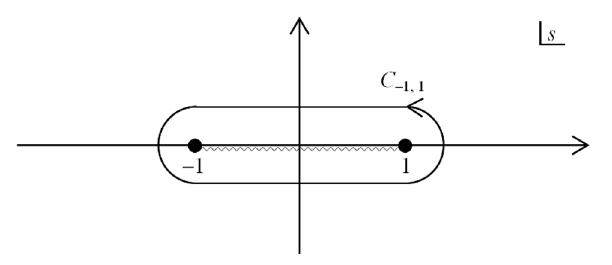
Figure 3 . The contour around [ (cid:0) 1 ;